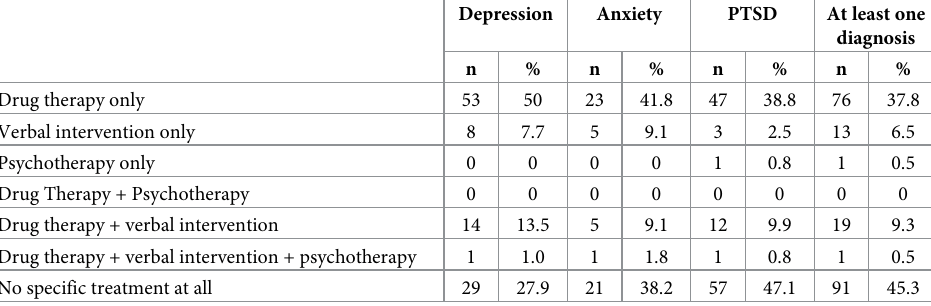
Table 2. Treatment combinations stratified according to